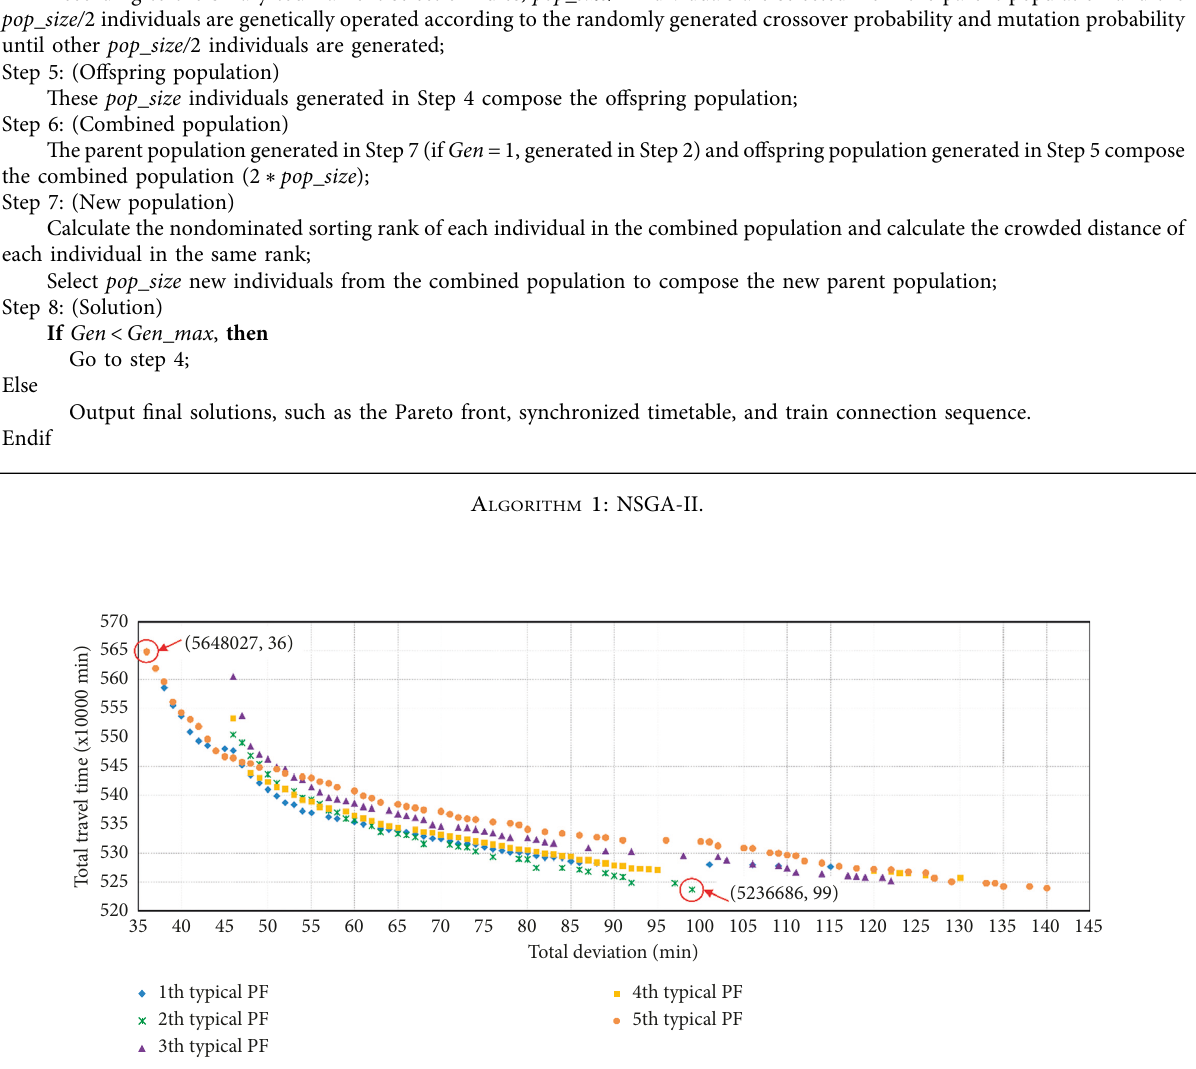
Figure 8: Pareto solutions of the large-scale